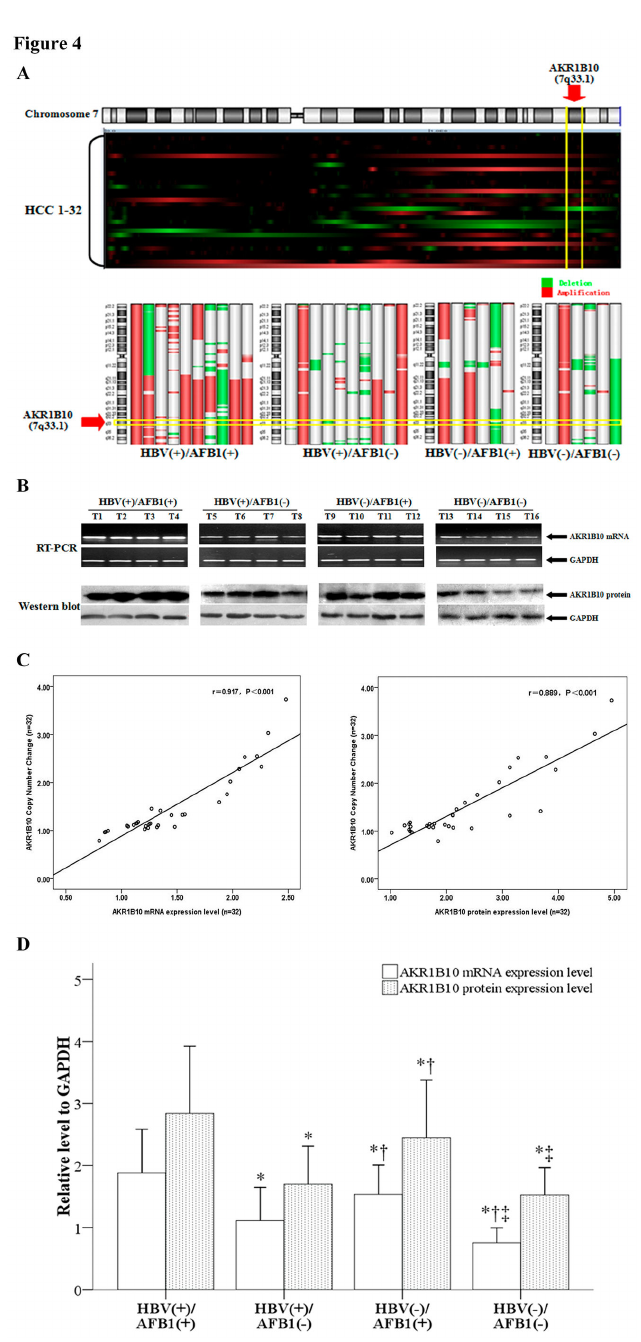
Figure 4. The AKR1B10 gene location and its expression levels validated by Reverse Transcriptase PCR and Western Blot. (A) AKR1B10 is located on RAR: 7q11.2-q35 (position 7q33.1) a chromosomal region that showed a high instance of instability in HBV(+)/AFB1(+) ,HBV(+)/AFB1(-) and HBV(-)/AFB1(+) groups. (B) Representative RT- PCR and Western blot images of AKR1B10 in the 4 groups. T1–T4 ,T5-T8, T9-T12 and T13-T16 were HCC samples obtained from HBV(+)/AFB1(+) , HBV(+)/ AFB1(-), HBV(-)/AFB1(+) and HBV(-)/AFB1(-) groups, respectively. Human GAPDH was used as an internal control. (C) The regression analysis showed a significant correlation between AKR1B10 expression level (both mRNA level and protein level) and AKR1B10 copy number. (D) RT-PCR and Western blot analysis of AKR1B10 expression. Mean mRNA and protein expression levels of AKR1B10 were calculated by RT-PCR and Western blotting for the 4 subgroups. Human GAPDH was used as an internal control. * indicated a significant difference ( P <0.05) as compared to HBV(+)/AFB1(+), †indicated a significant difference ( P <0.05) as compared to HBV(+)/AFB1(-), ‡ indicated a significant difference ( P <0.05) as compared to HBV(-)/AFB1(+). doi: 10.1371/journal.pone.0083465.g004 PLOS ONE |